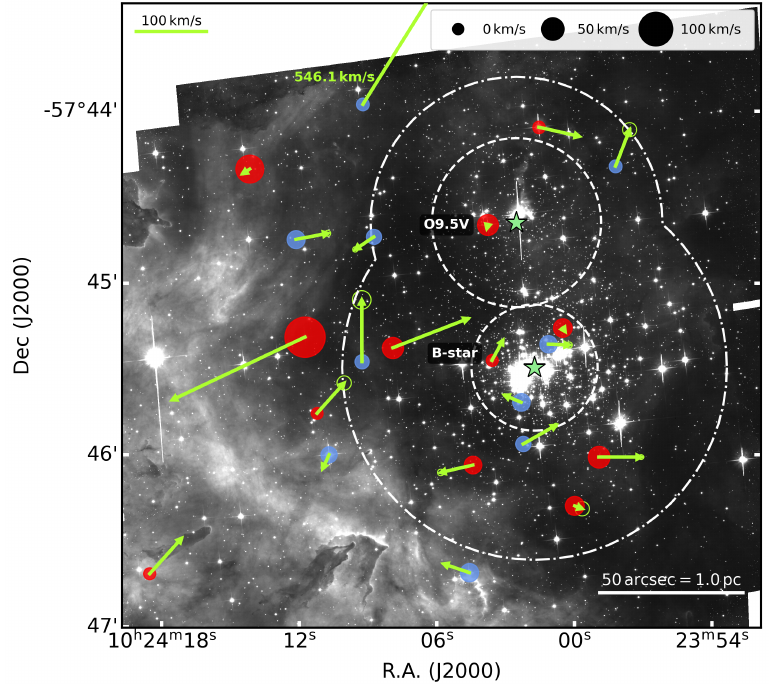
Figure 7. High-velocity stars moving away from Westerlund 2, identified from their proper motions and radial velocities. Reproduced from Zeidler et al. [204] with the permission of the authors and the